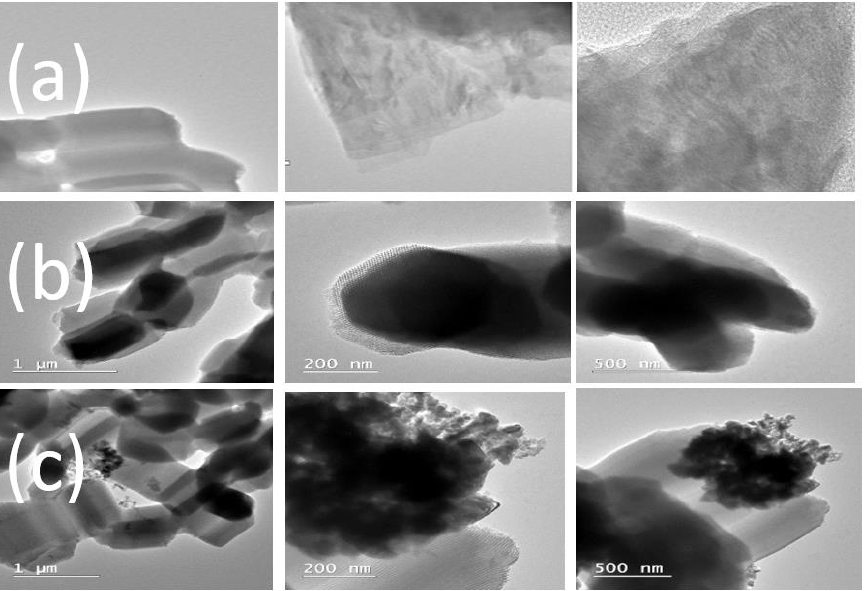
Figure 2. TEM images of the as-prepared ( a ) SBA-15; ( b ) ZnO/SBA-15; and ( c ) Ru-ZnO/SBA-15.